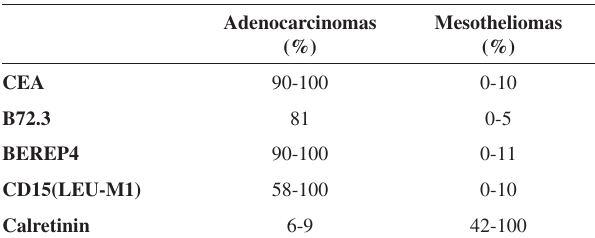
Table 3 - Positivity of immunohistochemical markers in adenocarcinomas and mesotheliomas 11, 25 Adenocarcinomas Mesotheliomas (%) (%) CEA 90-100 0-10 B72.3 81 0-5 BEREP4 90-100 0-11 CD15(LEU-M1) 58-100 0-10 Calretinin 6-9